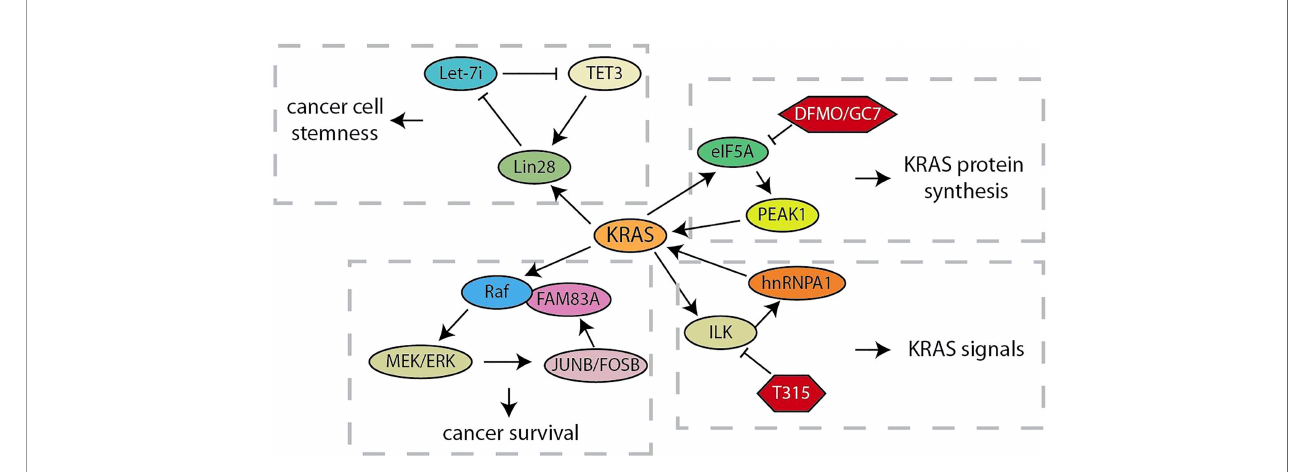
FIGURE 1 | Summary of KRAS related feedback loops in pancreatic